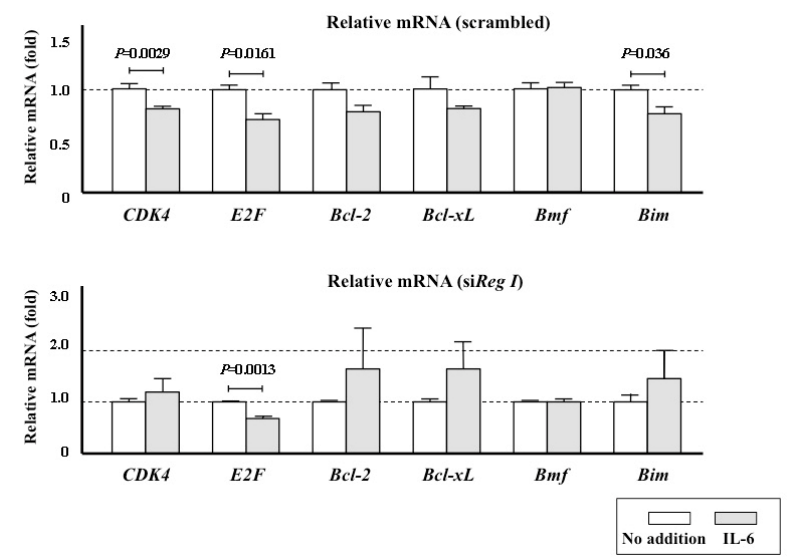
Figure 5. The expression of cell cycle-related ( CDK4 and E2F ), anti-apoptosis-related ( Bcl-2 and Bcl-xL ), and apoptosis-related ( Bmf and Bim ) genes in PMSCs. Scrambled RNA ( upper panel) or siRNA for rat Reg I ( lower panel) was introduced into the cells. The measurements were done without the addition of IL-6 to the medium (No addition) and with the addition of IL-6. The data are relative values compared with the mRNA levels from cells with “No addition” and are reported as mean ± SE ( n = 4).